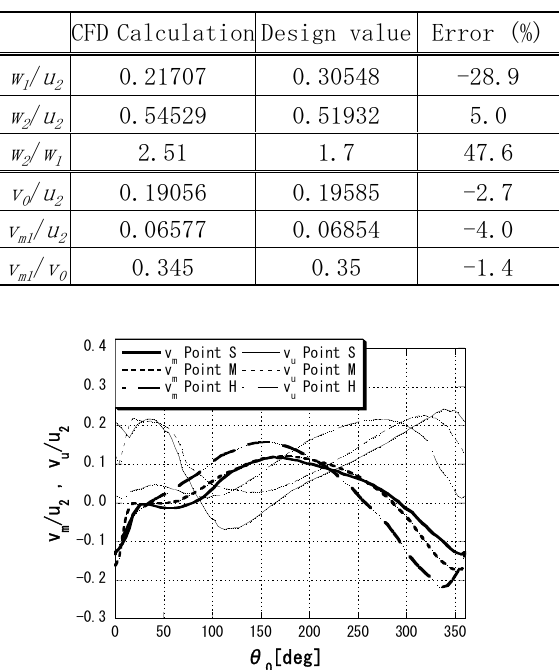
Table 2 Comparison of design parameter